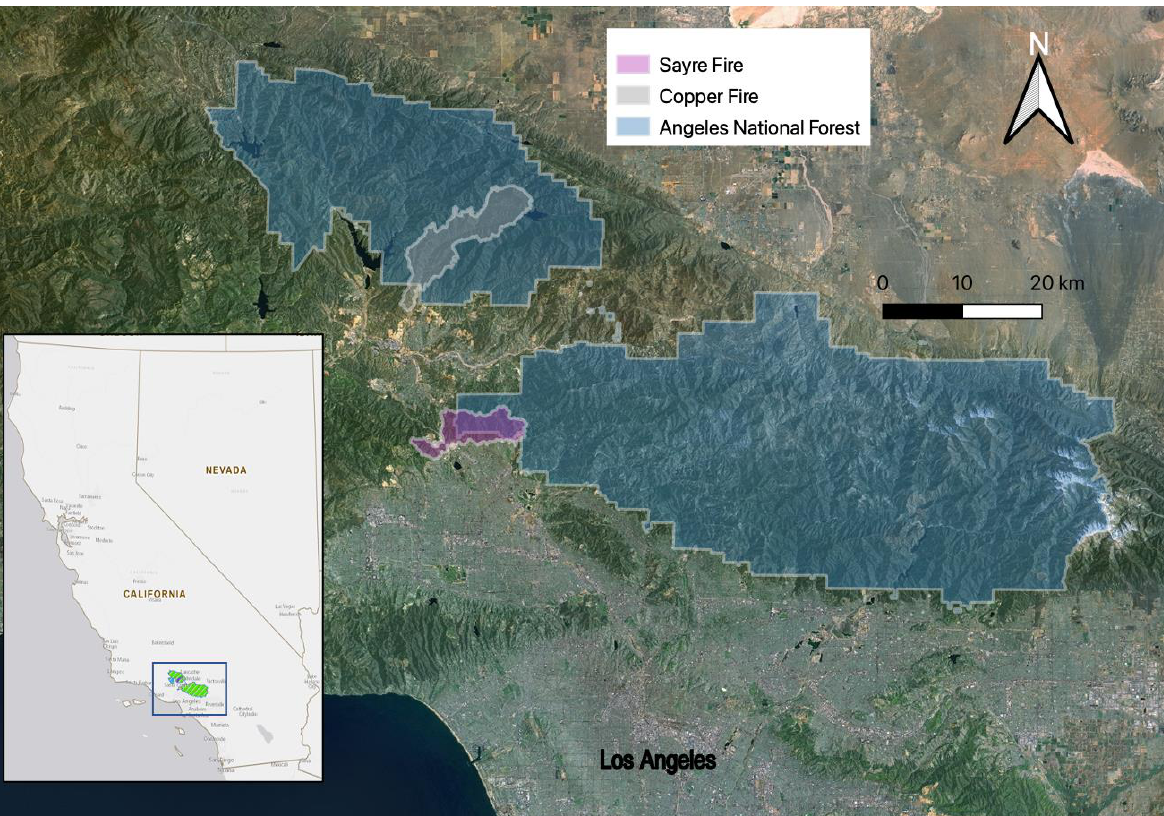
Figure 1. Map of the study area in the Angeles National Forest (green), Los Angeles County, CA, USA. The Copper and Sayre fires burned approximately 25,000 acres between 2002 and 2008.